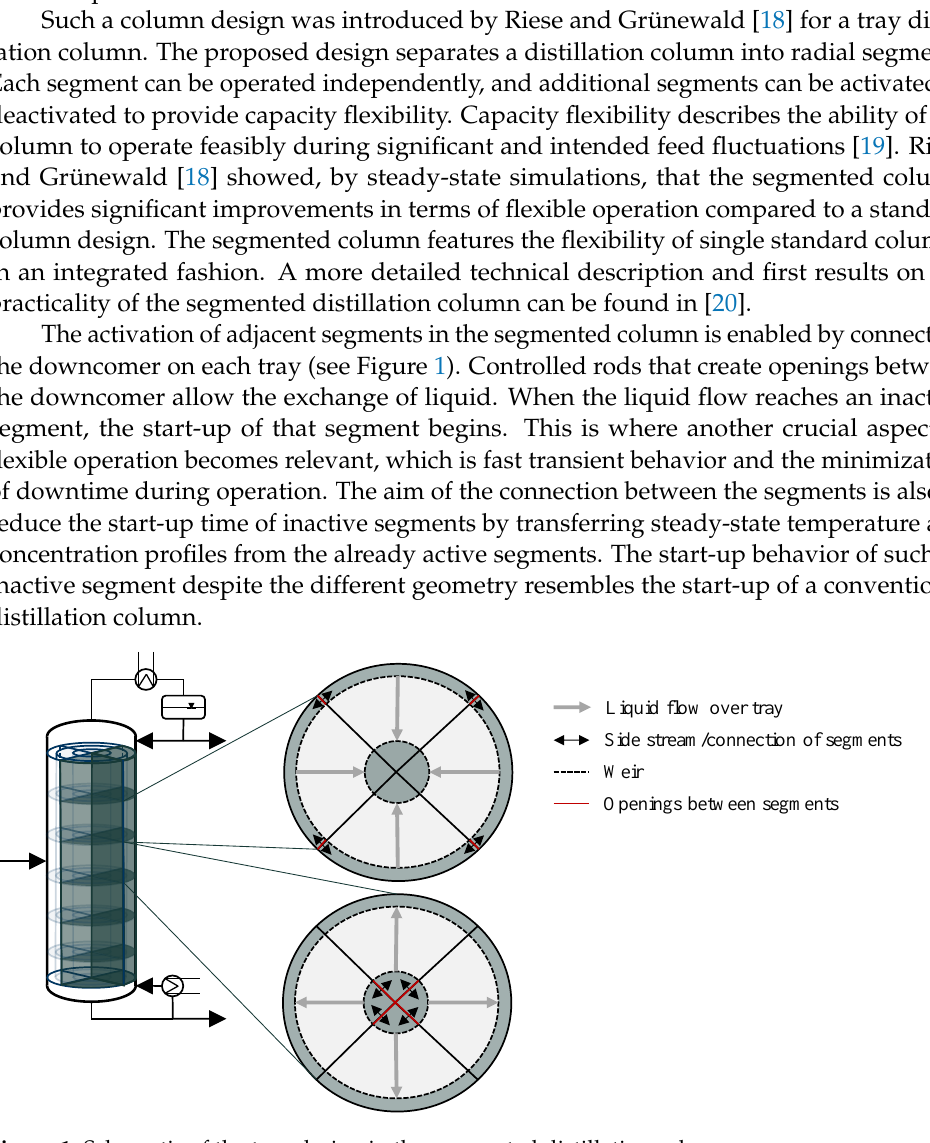
Figure 1. Schematic of the tray design in the segmented distillation column.